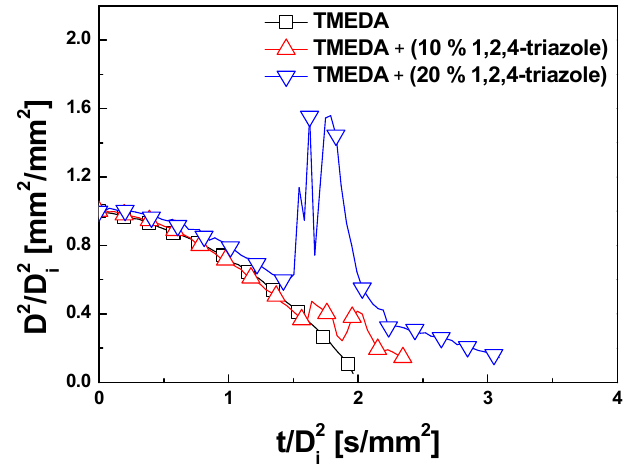
Figure 13. Normalized variation of evaporating TMEDA-based fuel droplet diameter squared with normalized time at 600 °C.